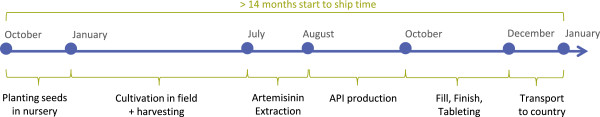
Timeline from planting to availability of final product.